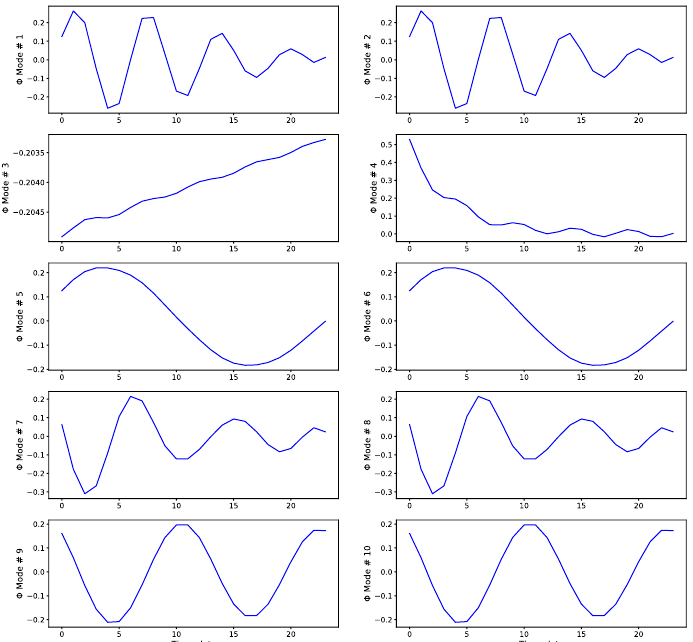
Figure 15. Principal eigenvectors ( Φ ) of the DMD algorithm (best linear mapping) for the temporal evolution of the load values. The eigenvectors are in order of importance (according to their corresponding eigenvalues) and represent the main modes of temporal evolution of the time-series. They clearly show the strong intra-day periodicity of the load values. The values shown correspond to a rolling window of 24 h (1 day). Appl. Sci. 2021 , 11 , x FOR PEER REVIEW